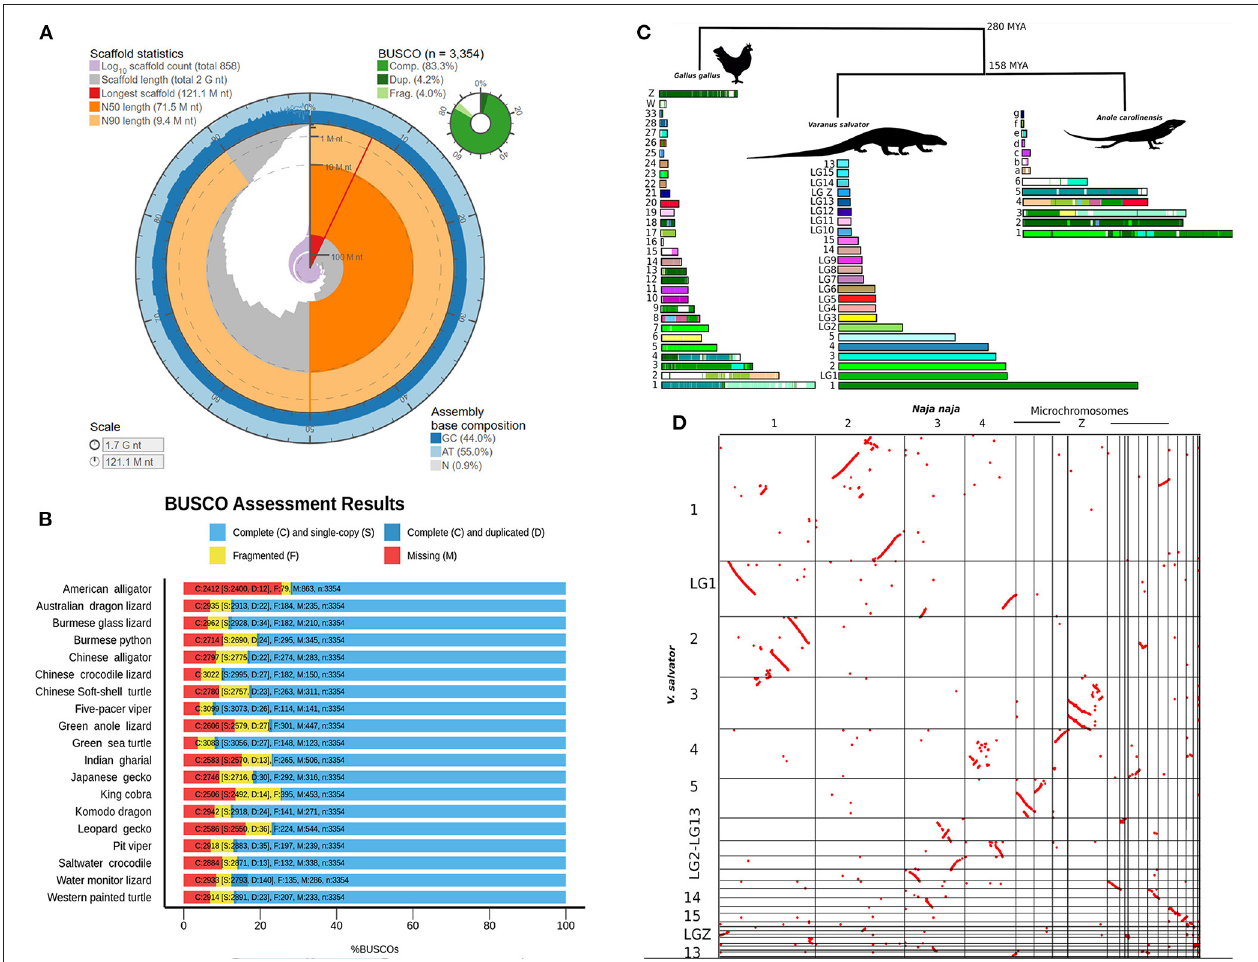
FIGURE 1 | Varanus salvator genome completeness detail and comparative analysis. (A) Genome assembly statistics visualization of V. salvator . (B) Bar chart with summary assessments for the proportion of genes present in 19 non-avian reptile genomes. The summary assessment shows the proportions classified as complete (C, blues), complete single-copy (S, light blue), complete duplicated (D, dark blue), fragmented (F, yellow), and missing (M, red). (C) The cross-species syntenic comparison among V. salvator, G. gallus , and A. carolinensis genomes. The same color indicates a syntenic pattern between chromosome and V. salvator pseodchromosomes. (D) Dot plot showing patterns of chromosomal rearrangement between V. salvator and N. naja